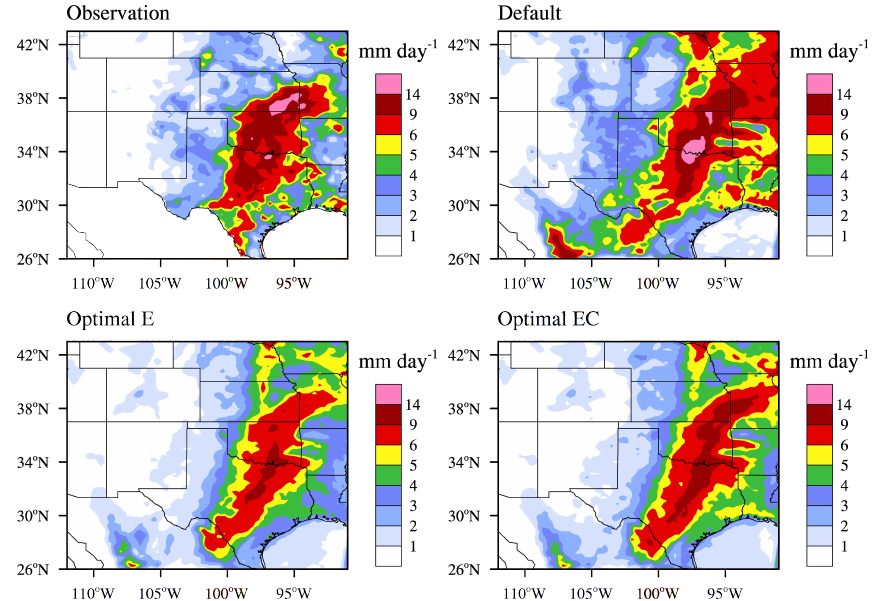
Fig. 5. Spatial distributions of observed and simulated (25km) monthly mean precipitations over SGP for June 2007, with default and optimized (based on E or EC ) parameters in the KF scheme.